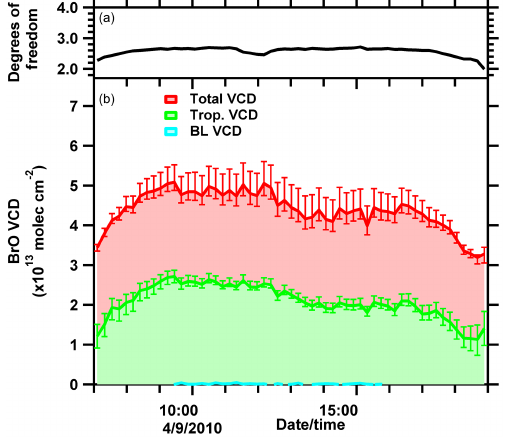
Figure 6. Diurnal variation in the BrO vertical profiles represented as partial VCDs for the BL (0–1km), troposphere (0–15km), total (0–50km) (b) , and the total DoFs from the inversion for each pro- file in (a) . The error bars on the VCDs indicate the range of values retrieved using the three different a priori